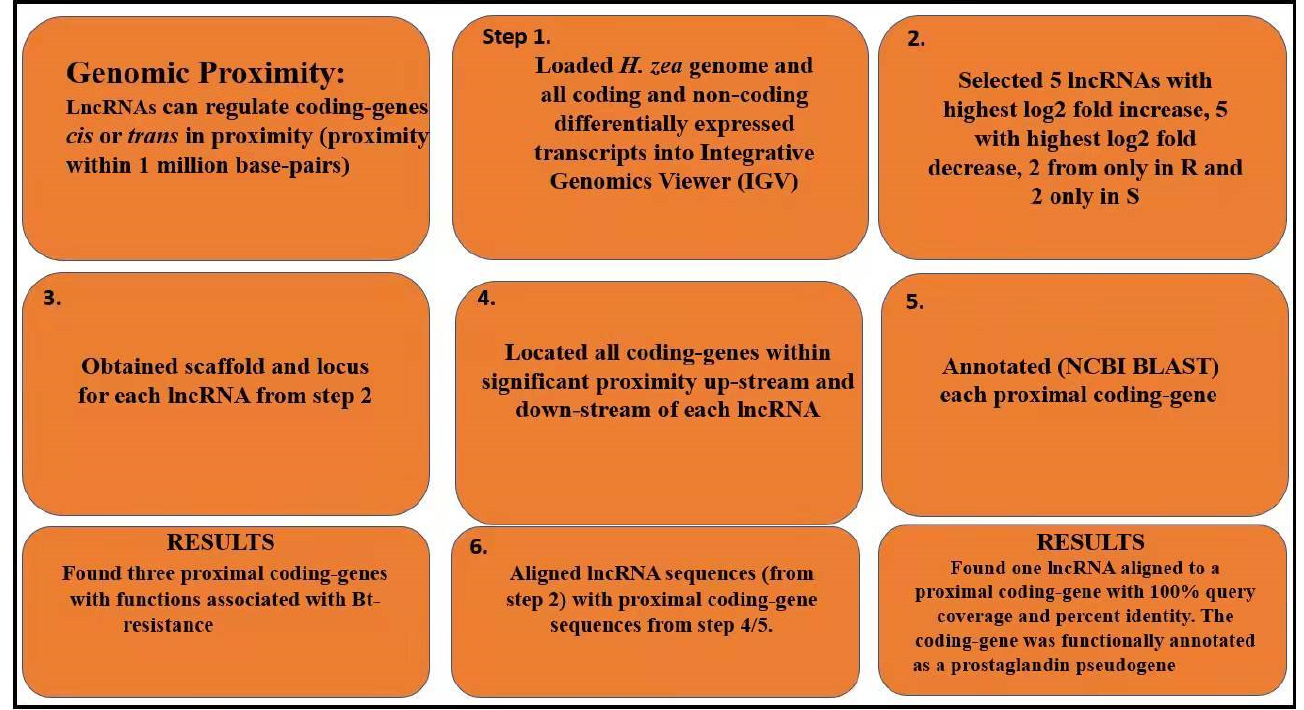
Figure 3. Workflow for identifying statistically differentiated lncRNAs coding genes in toto and those with functions known to have a role in Bt-resistance that are proximal to statistically differentiated lncRNAs. Proximity measurements were limited by the size of the scaffolds, even though proximity is defined as 1 million base pairs cis and trans from the lncRNA. For each proximal coding gene and lncRNA, a BLASTn alignment was also conducted to assess potential pseudogenes.